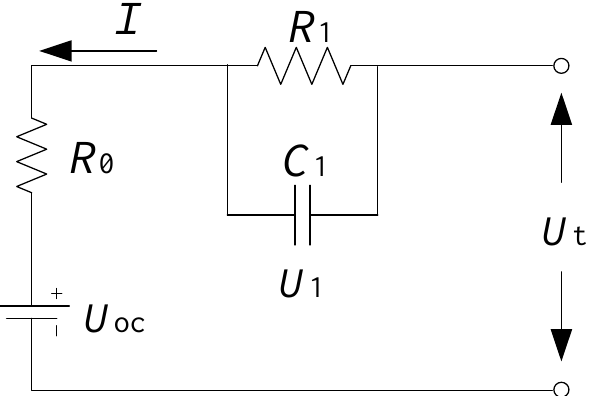
Figure 1. Thevenin equivalent circuit model.